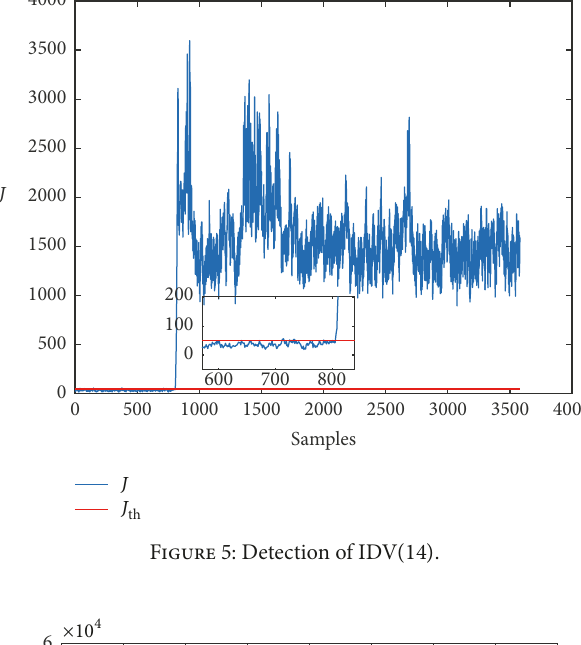
Figure 5: Detection of IDV (14) .